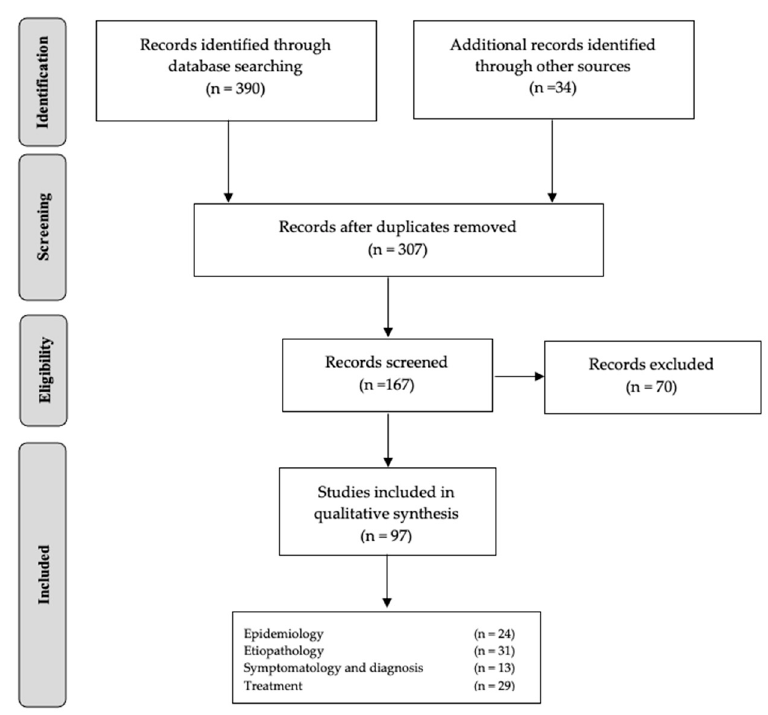
Figure 2. Flow diagram of the study selection.